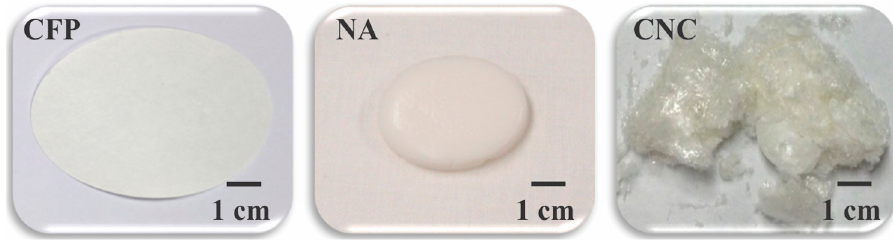
Figure 1. Images of the cellulosic (CFP) and nanocellulosic (NA and CNC) transducers.